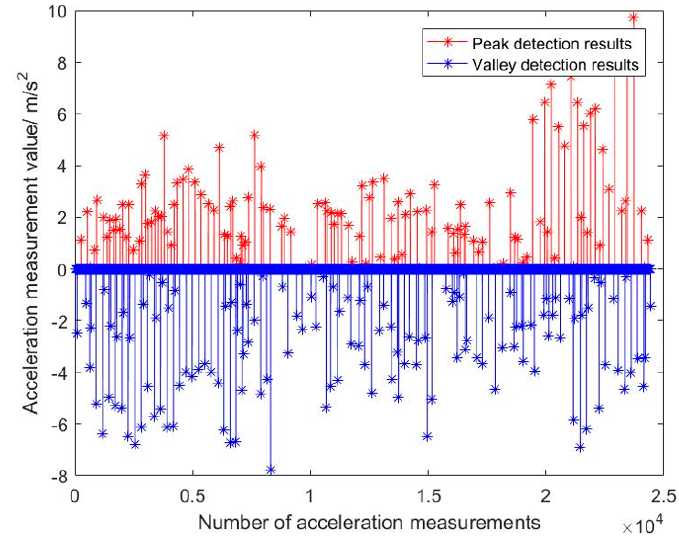
Figure 11. Detection results of Peak and Valley of pedestrian motion acceleration wave.